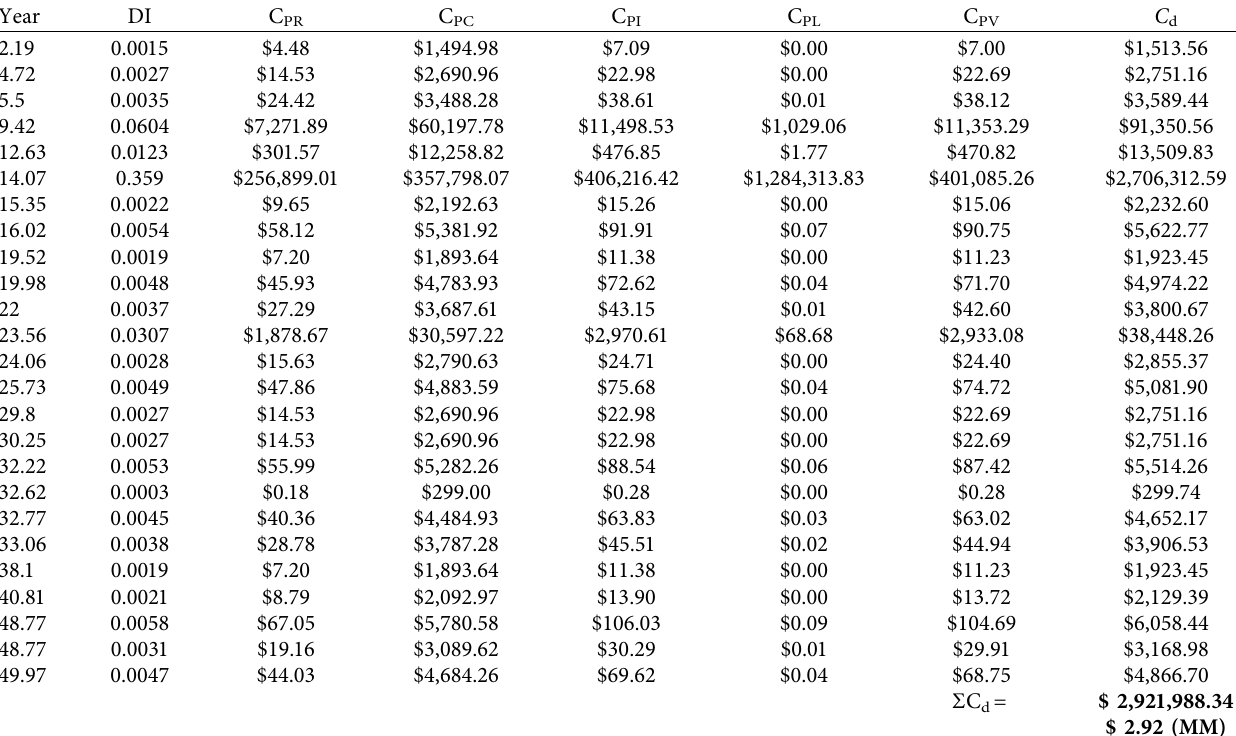
Table 8: Expected damage cost in the life-cycle of the 12-story